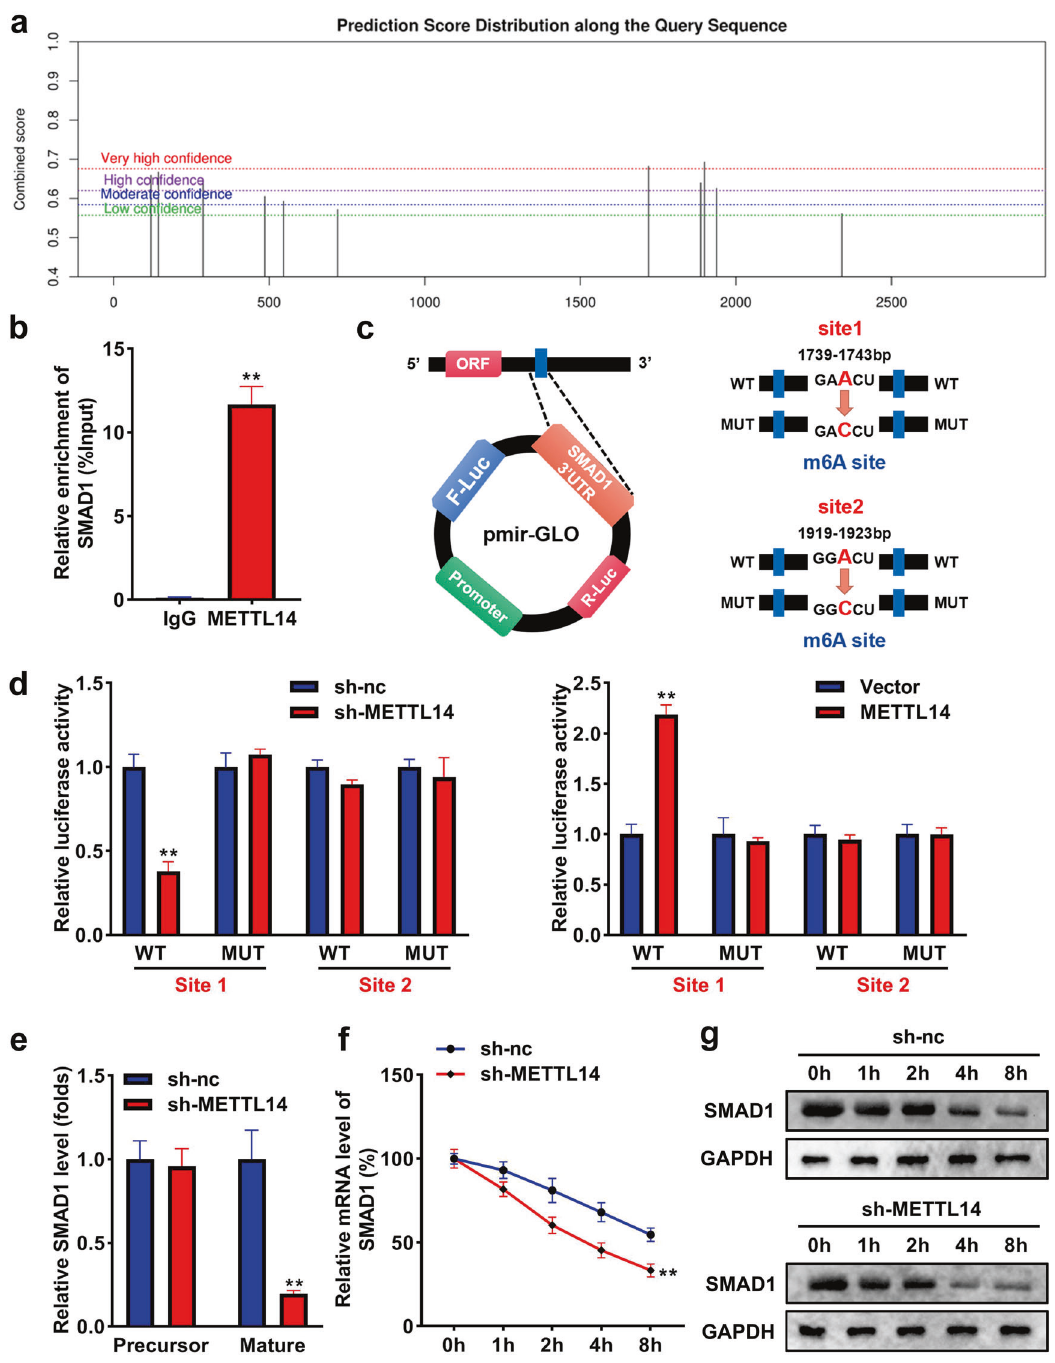
Fig. 6 METTL14 promotes m6A methylation of SMAD1. a m6(A) methylation sites of SMAD1 were predicted using the SRAMP database. b The combination between METTL14 and SMAD1 was analyzed using RIP assay. c The potential bindings sites in SMAD1 were shown. d The luciferase reporter analysis evaluated which site of SMAD1 could be bound to METTL14. e Precursor and maturation of SMAD1 levels were assessed using qRT-PCR. f The stability of SMAD1 at the mRNA level. g The stability of SMAD1 at the protein level. * *P <